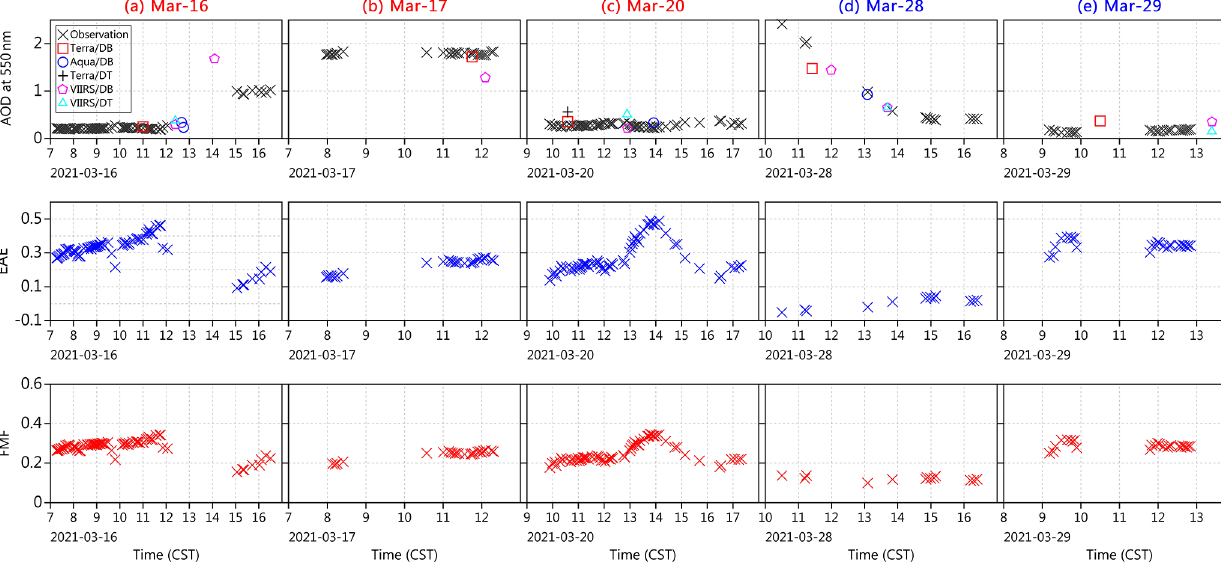
Figure 5. Daily variation of AOD at 550nm (top row), EAE between 440 and 870nm (middle row), and FMF (bottom row) at Beijing- CAMS site during (a–c) the 3.15 event and (d, e) the 3.27 event. The instantaneous AOD values from the MODIS and VIIRS sensors, which were derived using the Dark Target (DT) and Deep Blue (DB) algorithms, respectively, are given in the top